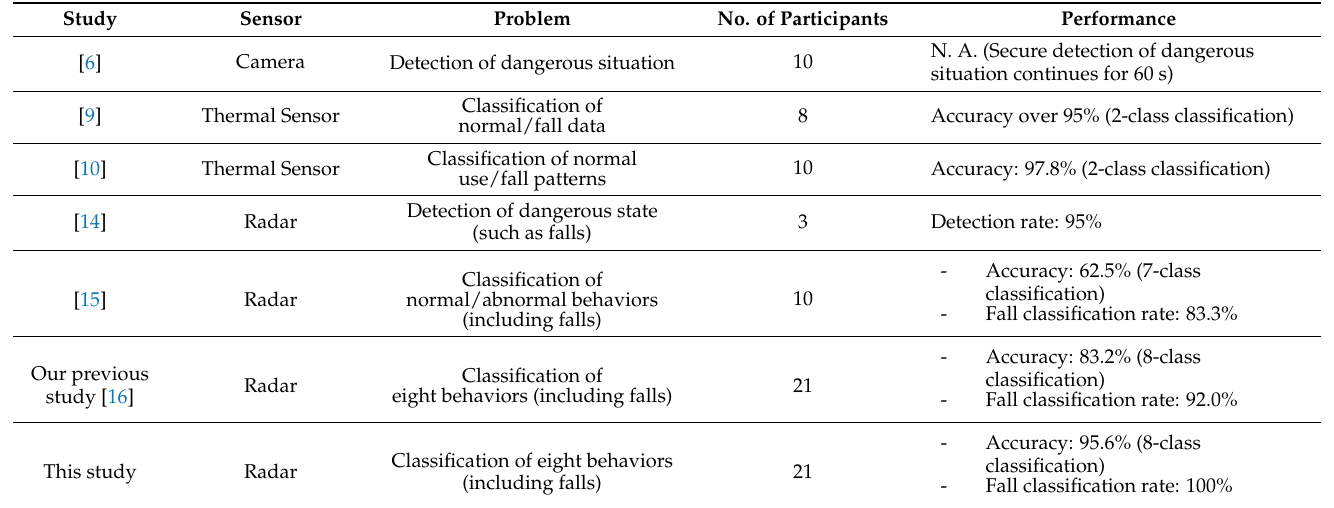
Table 7. Comparison of studies on restroom